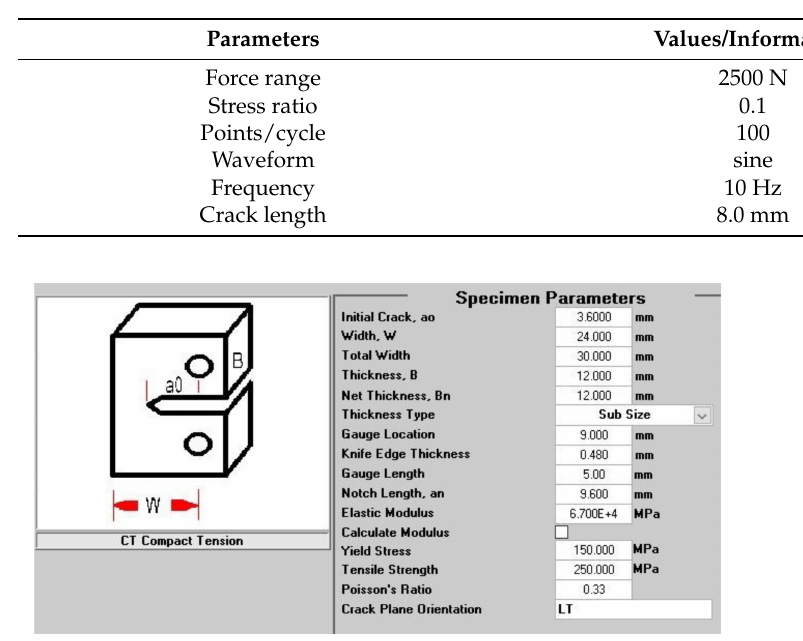
Figure 4. Testing fixture with CT specimen. Table 3. Setting general testing parameters.